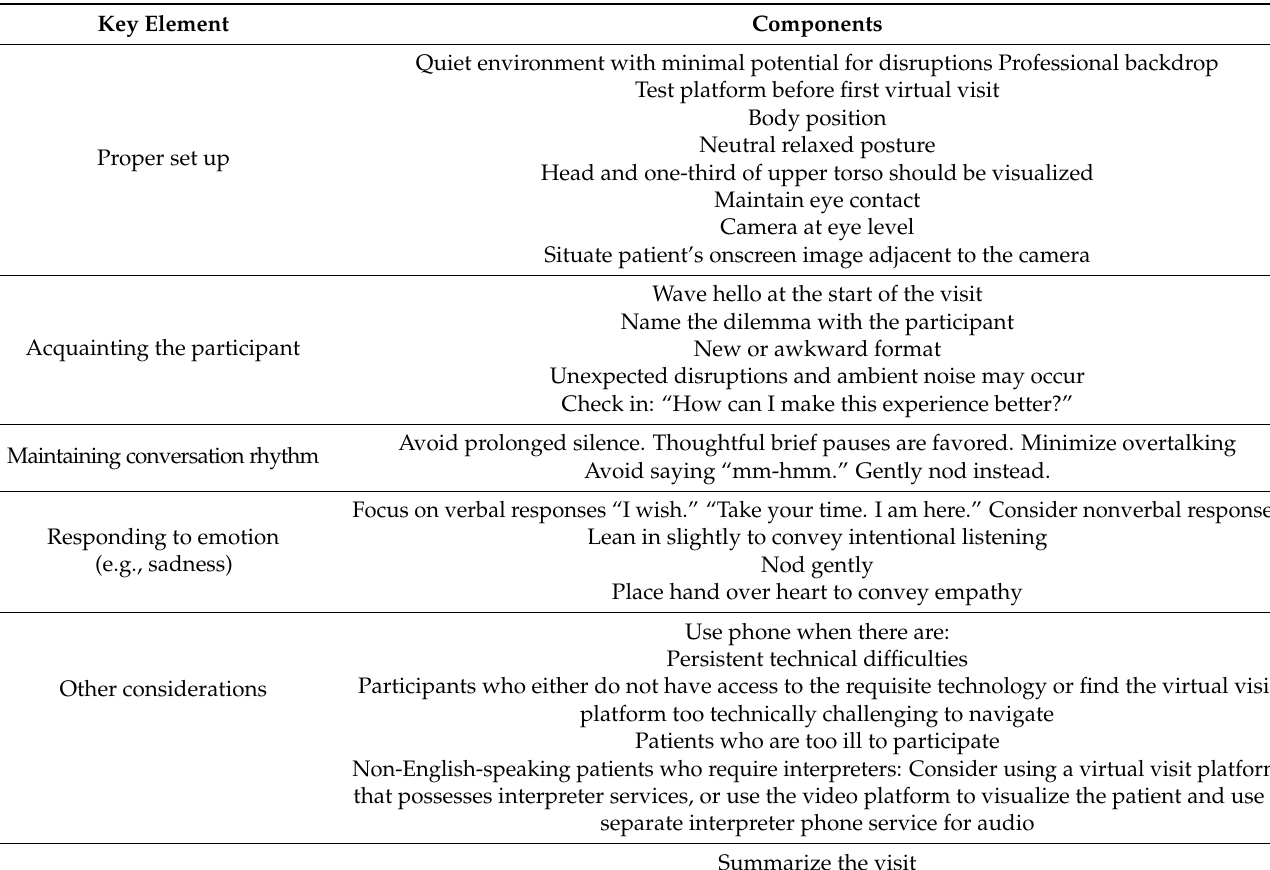
Table 1. Key Elements and Components of Webside Manner